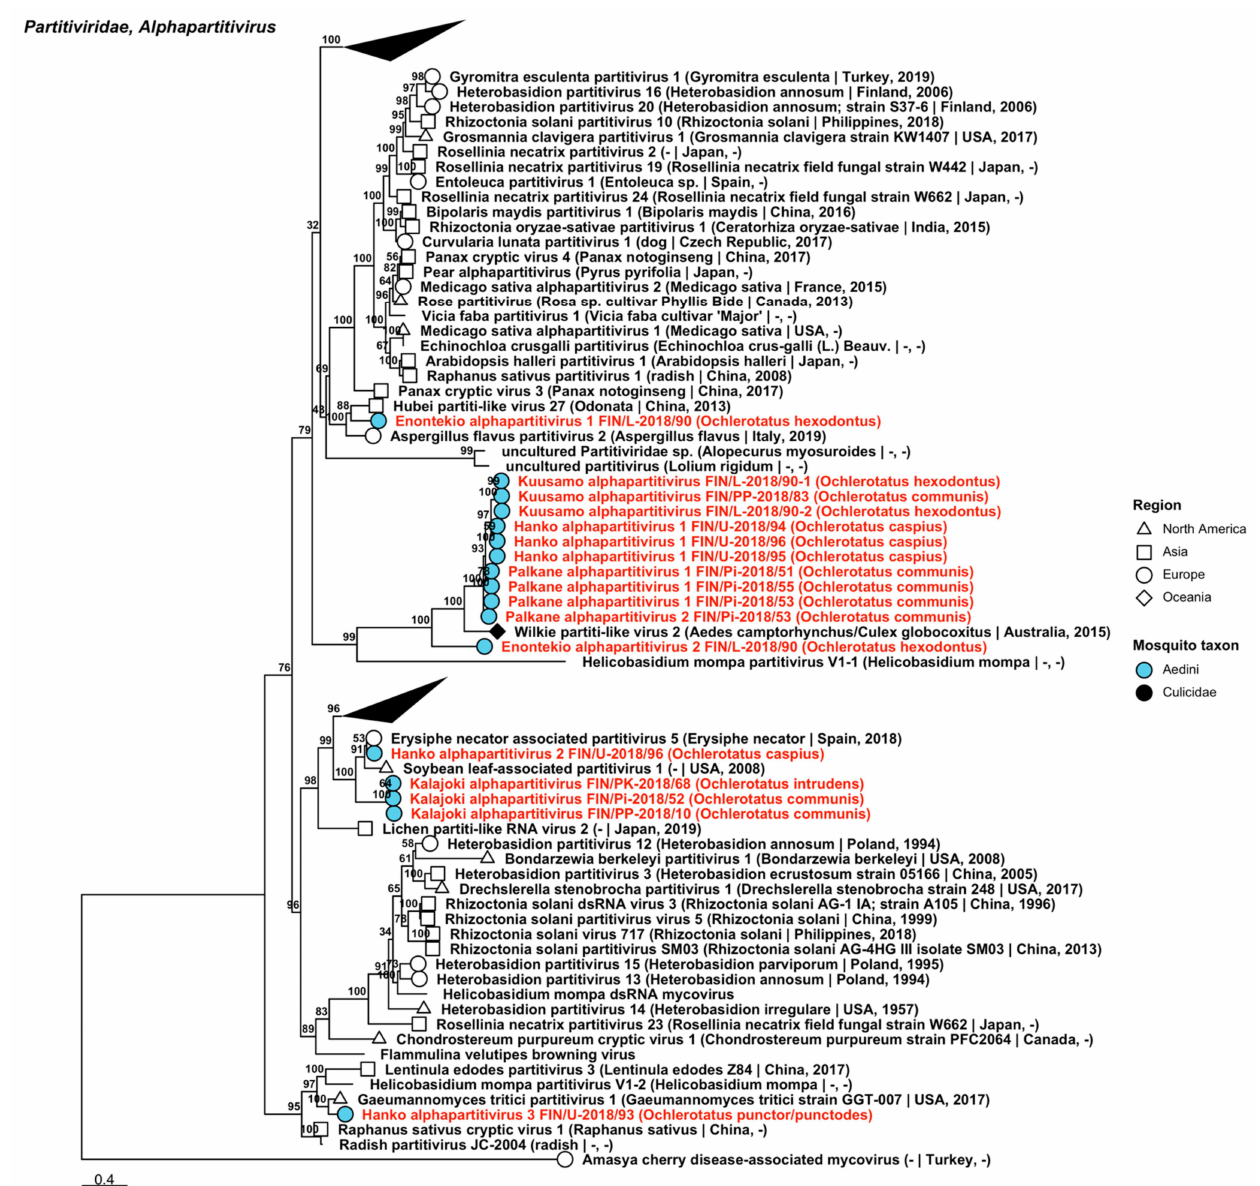
Figure 17. Maximum likelihood tree of Alphapartitivirus ( Partitiviridae ). Tentative novel viruses are displayed in red, with the mosquito species from which they were derived in parentheses. Sequences from GenBank are black and display the following information after the virus or species name: “(sampled organism(s)|collection country, collection year)”. Tip colours represent the tribe of mosquito from which viruses were obtained. Tip shape represents the continent or region from which the specimens were collected. Trees were constructed from amino acid sequences of virus polymerases >1000 nt, aligned with MAFFT and computed with IQ-TREE2 using ModelFinder and 1000